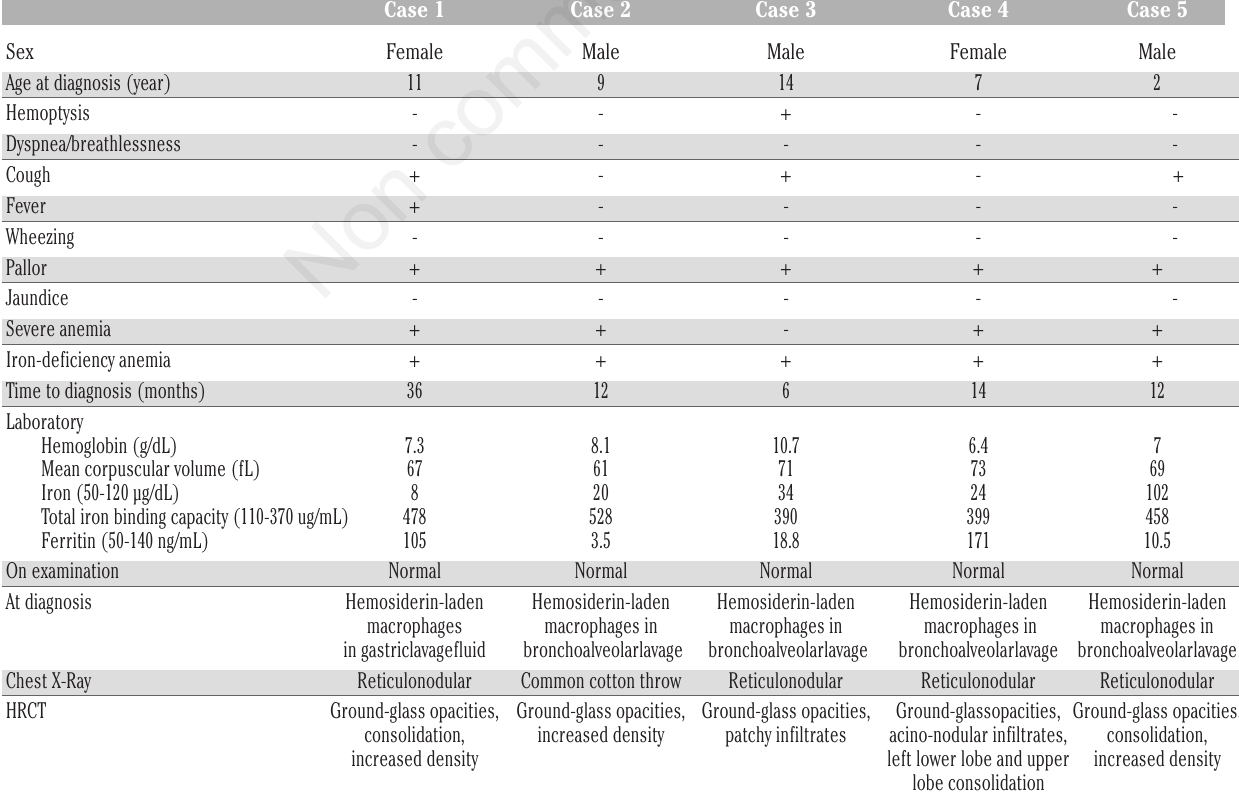
Table 1. Clinical profile and laboratory of patients with idiopathic pulmonary hemosiderosis.